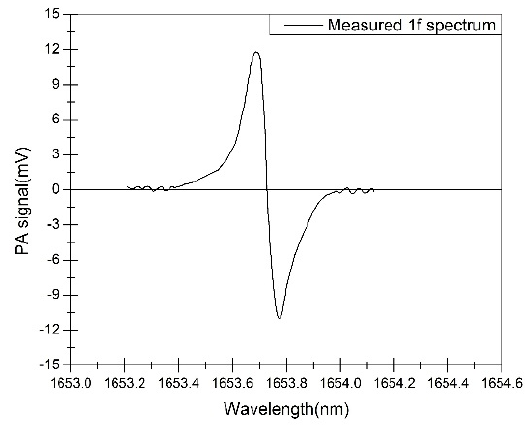
Figure 7. Measured 1 f spectra of 200 ppm CH 4 .